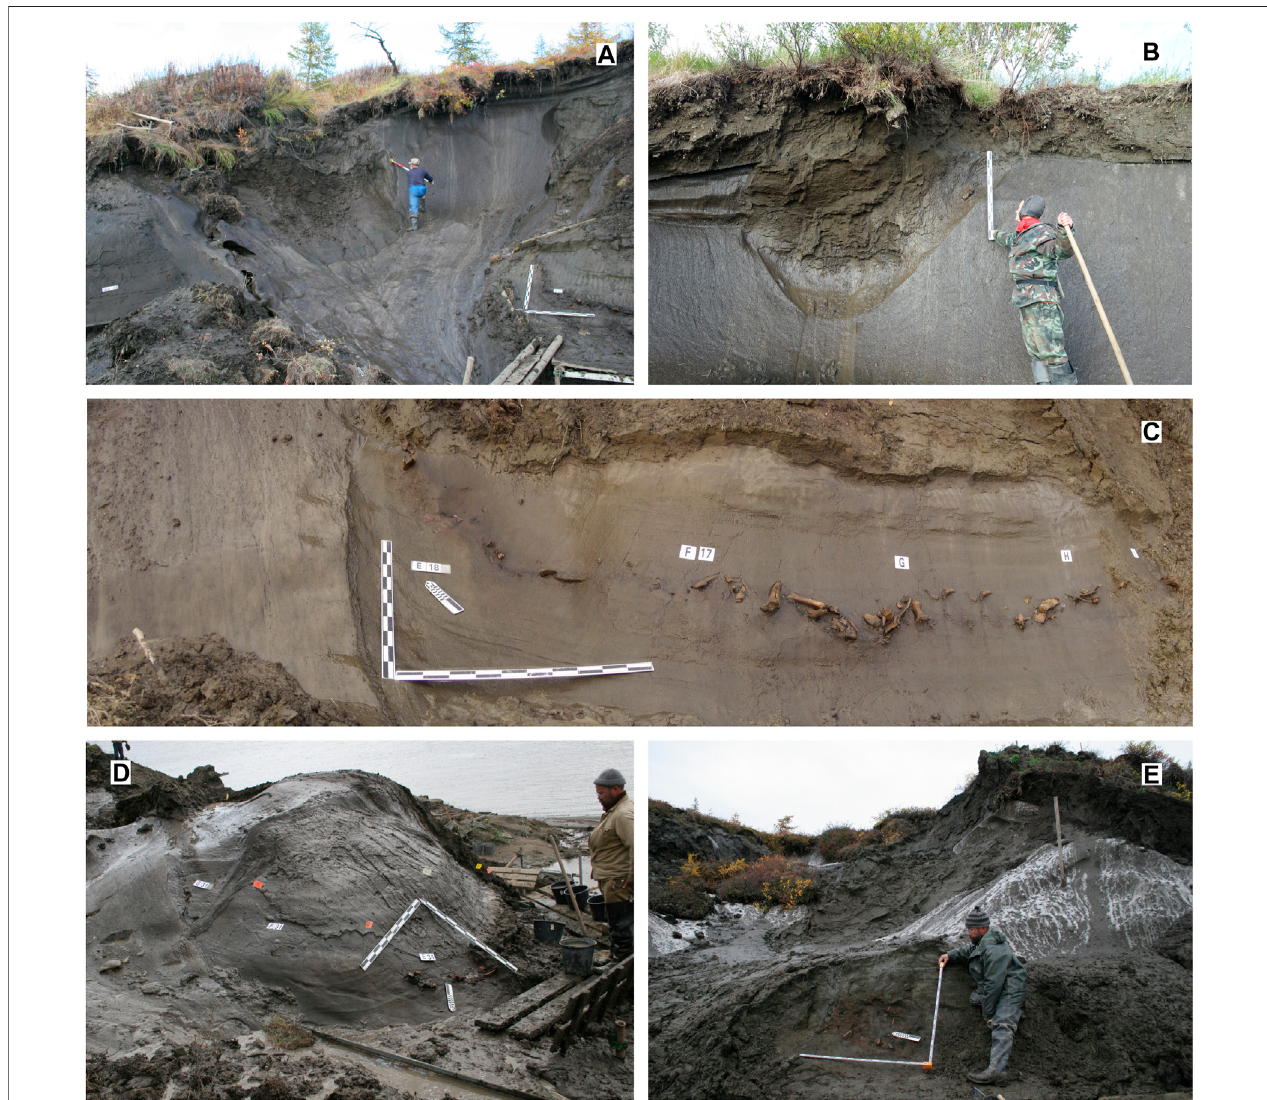
FIGURE 11 | Vertical deformations of the cultural layer related to the growth of the ice wedges belonging to the oldest (MIS3) generation dissecting Member 3 deposits: (A) positionoffrozen insitu culturallayerbendedupfollowingtheice-wedgecontact(intherightpartofthepicture)andhypsometricpositionofbonestraveled up from the cultural layer and found 1.5 m below the second terrace (T2) brow (central upper on the picture), viewed from the South, NP area, excavations of 2005; (B) position of the cultural layer with deformations and a bone moved up alongside the ice wedge almost to T2 brow, the bone is found at 1.2 m depth below the presentsurface,viewfromtheSouth,YanaBexcavationarea,excavationsof2016; (C) culturallayerobservedinthefrozenverticalwall:subhorizontalstripofthecultural layersharplybends up in1 mdistancefrom MIS3 ice-wedgemargin, view from South-Southwest,NP area,2004; (D) vertical deformation ofthe cultural layer alongside the contact of the ice wedge and polygon deposit, viewed from the North, Northern point, 2007; (E) portion of the cultural layer in vertical position near the boundary between MIS3 ice wedge and the polygon deposit, viewed from the West, NP, 2006.